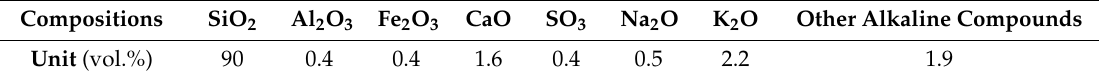
Table 6. Chemical composition of the silica fume [35].